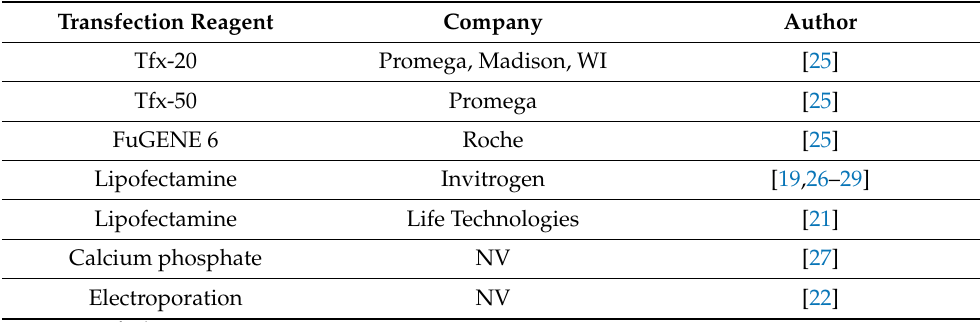
Table 3. Summary of the transfection reagent used throughout the